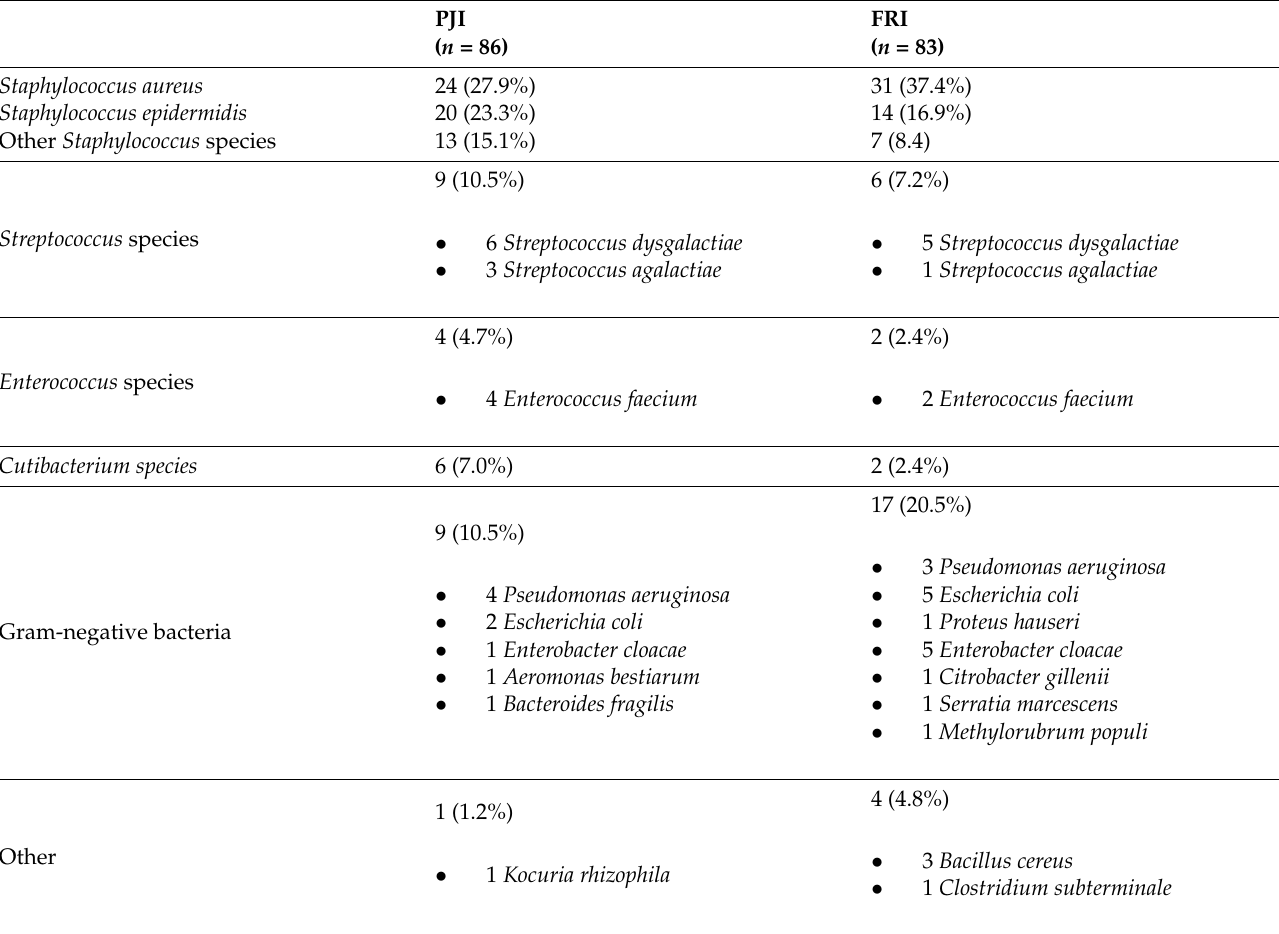
Table 2. Isolated